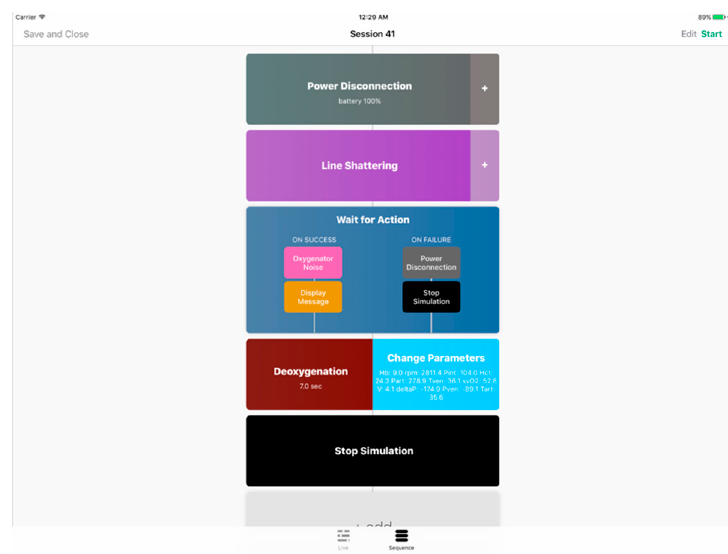
Figure 10. The instructor app showing the sequence manager view.